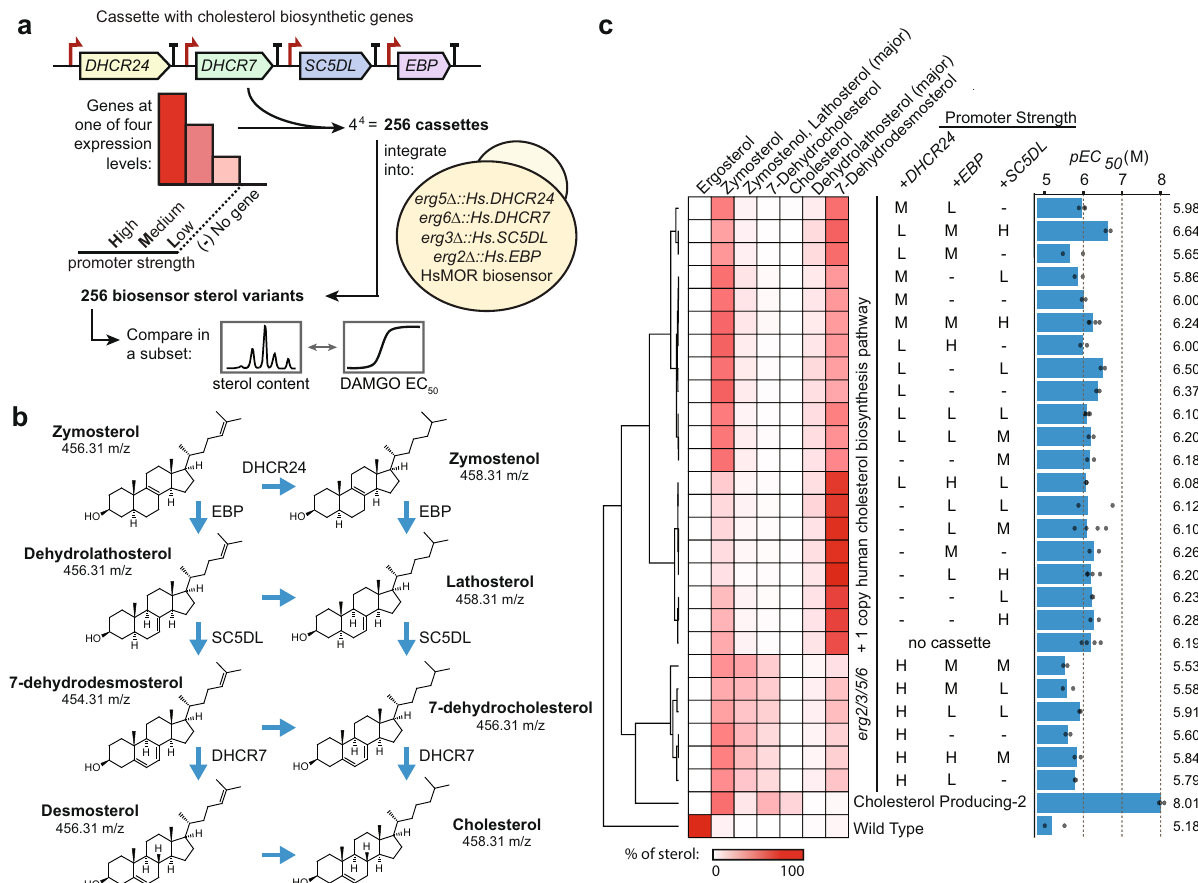
Fig. 6 The effect of membrane sterol composition on opioid biosensor signaling ef fi ciency. a Construction of an array of putative biosensor strains with systematically varied promoter strength for the cholesterol biosynthetic genes downstream of zymosterol. Cassettes containing these genes under different promoters were integrated into an HsMOR biosensor background with an additional copy of these enzymes in place of the fi nal ergosterol biosynthetic genes ( ERG2/3/5/6 ). b Cholesterol biosynthesis intermediates after zymosterol. c Sterol analysis and full dose responses with DAMGO of 39% of biosensors from the collapsed screen. 10,000 cells/strain/replicate, n = 2, 3 or 4. Percentages of total sterol content for the intermediates were determined and mean pEC 50 s were calculated. Source data are provided as a Source Data fi